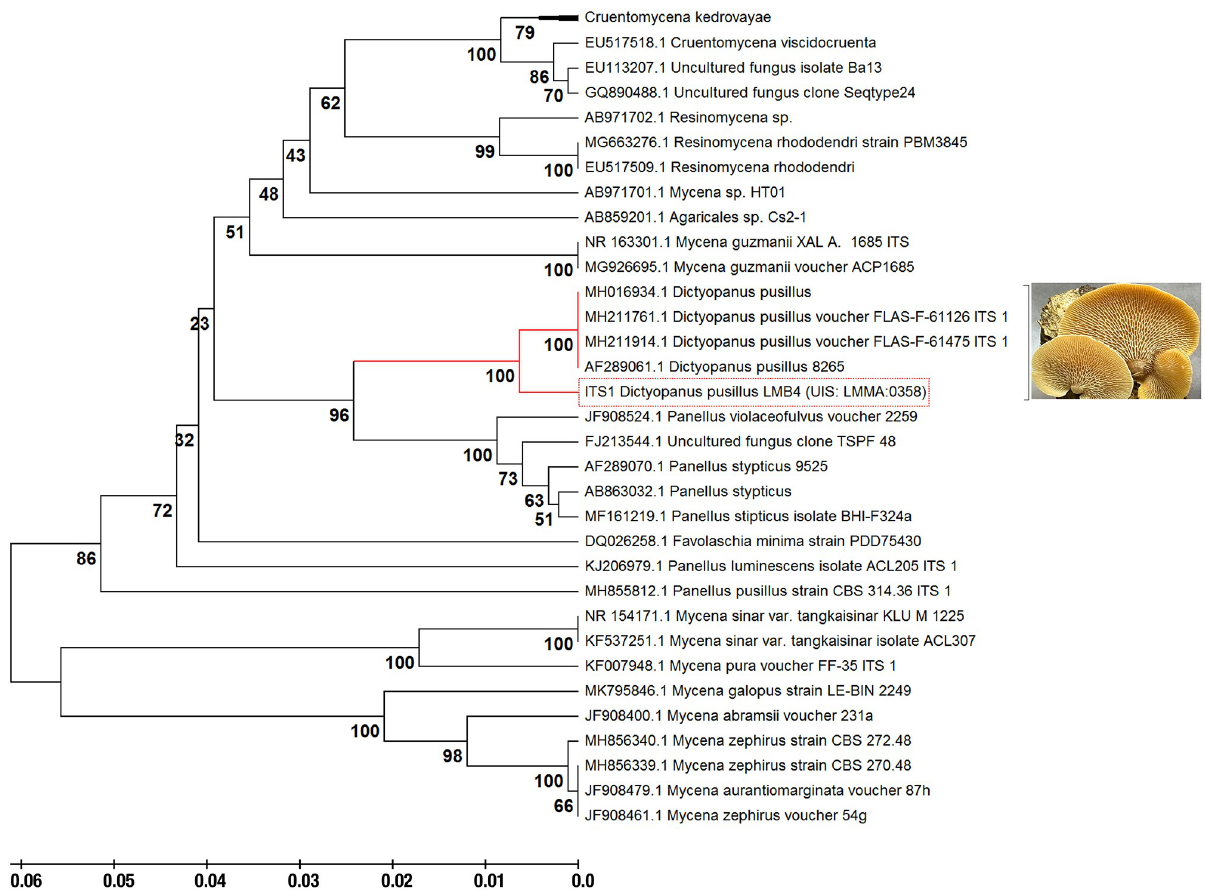
Fig 2. Phylogenetic analysis of the pre-identified isolates labeled as Dictyopanus sp. We used the ITS region 1 as the genetic marker to infer the evolutionary history of this fungus using the UPGMA protocol (see Materials and methods for details). The optimal tree analysis shows a branch length of 0.60, with clustering of species after a bootstrap of 500 replicates using the Maximum Composite Likelihood method to obtain evolutionary distances between members. The species was identified as Dictyopanus pusillus . The phylogenetic tree was drawn to use the same branch length units as those of the evolutionary distances. This analysis was performed using the standalone MEGA software, version